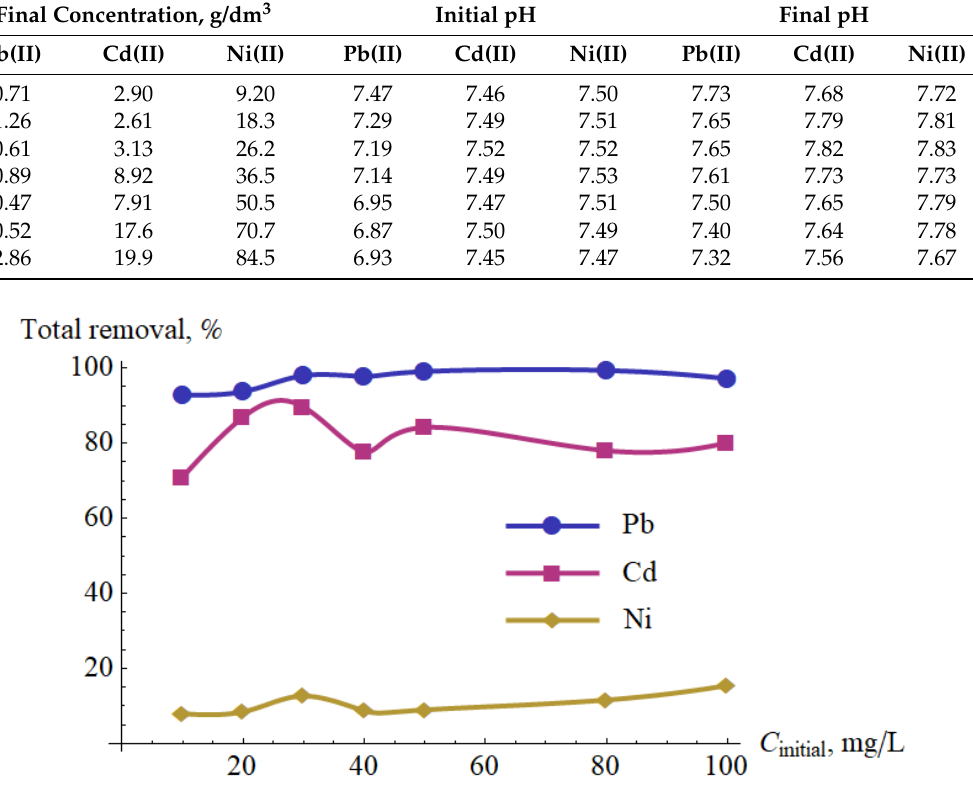
Figure 10. Percentage removal of Pb(II), Cd(II) and Ni(II) after one pass versus the initial concentra- tion.